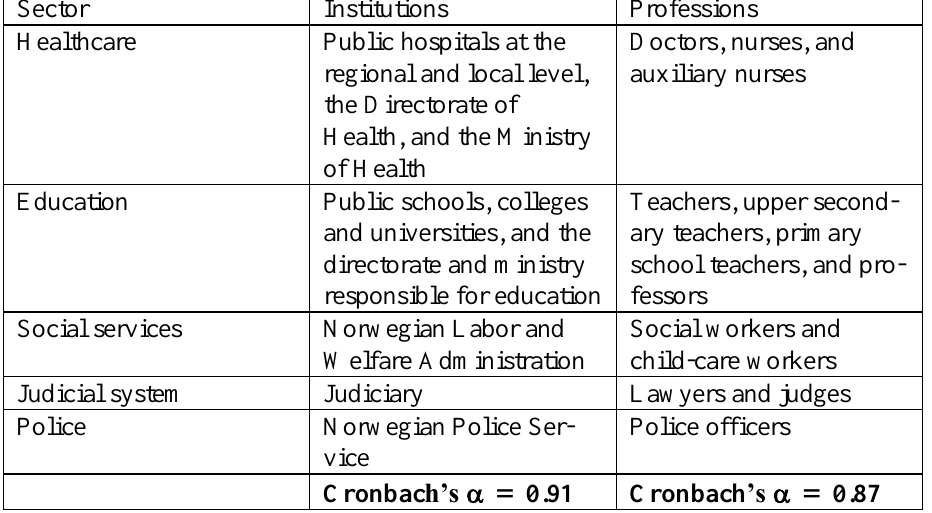
Table 1. Overview of welfare institutions and professions included in the